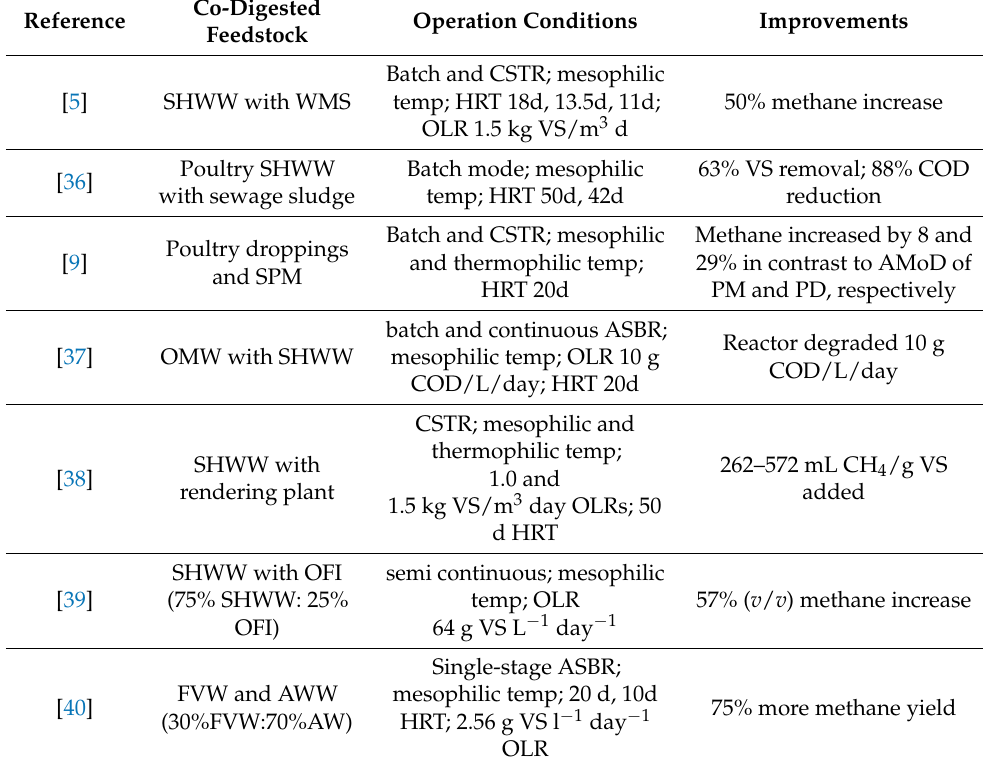
Table 1. Performance of the ACoD of slaughterhouse wastes with different